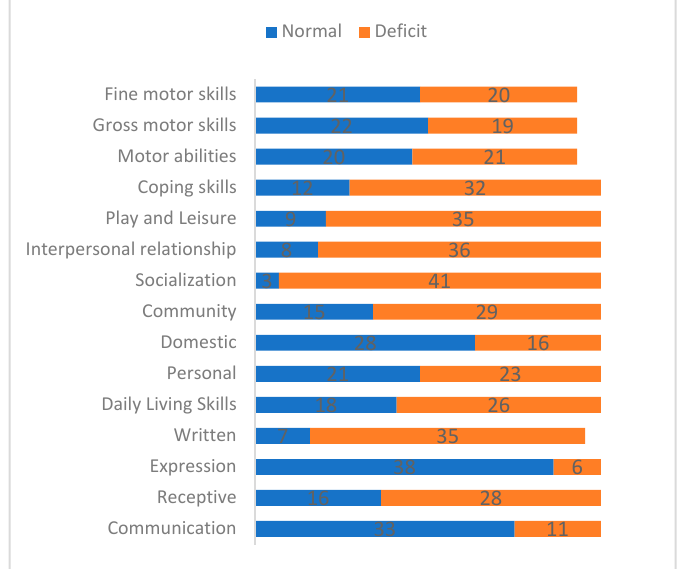
Figure 3. VABS adaptive functioning domain T scores of patients comparing with Italian norms: Deficit and normal categories.